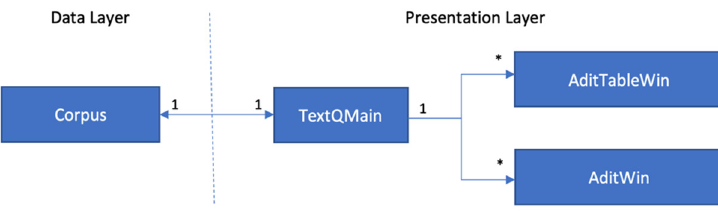
Figure 6. Software Architecture for TextQ.